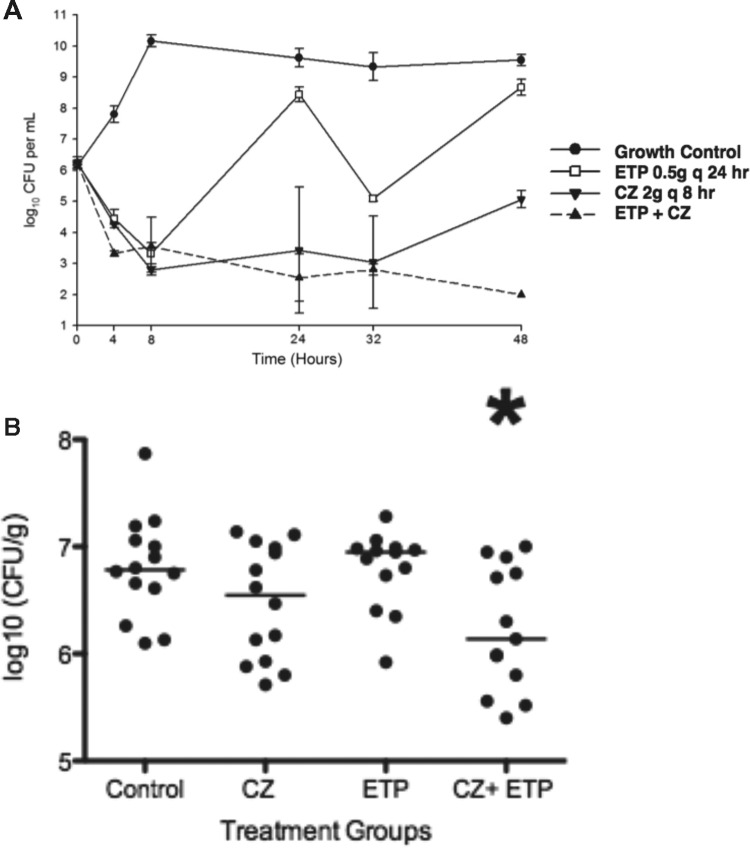
(A) Simulated pharmacokinetic/pharmacodynamic modeling of MSSA rus276 employing CZ and ETP alone or in combination at clinically relevant concentrations. Only the combination regimen of ETP plus CZ achieved bactericidal activity at 24 and 48 h, and CZ plus ETP showed significantly lower CFU at 48 h than the other groups (P < 0.01; one-way ANOVA with Tukey's post hoc test). The error bars indicate standard deviations. (B) Bacterial counts in excised skin tissue of mice treated with CZ, ETP, or both drugs versus no antibiotics (control). The horizontal bars indicate the medians of the groups. Only the combination treatment group (CZ+ETP) showed bacterial counts less than those with the control (*, P < 0.02; Mann-Whitney U test). Control versus CZ (P = 0.17) and control versus ETP (P = 0.87) were not statistically significant.